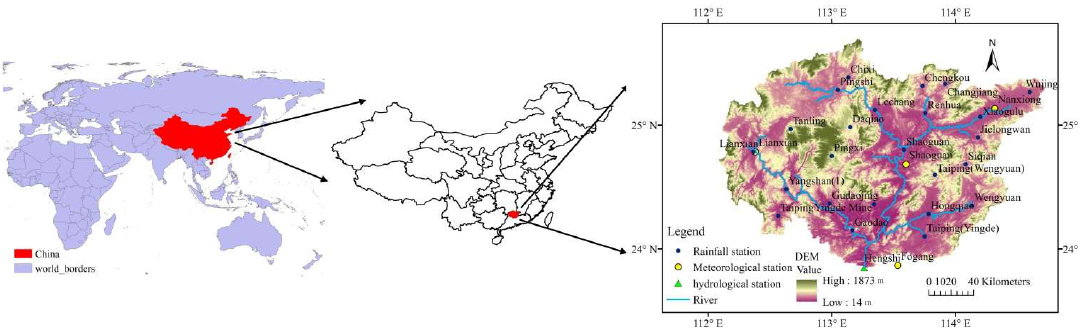
Figure 1. Location, topography, and stations of the Feilaixia catchment.